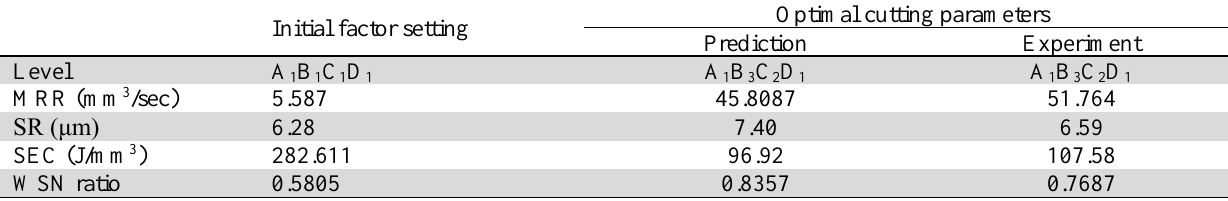
Results of the confirmatory experiment for WSN ratio method